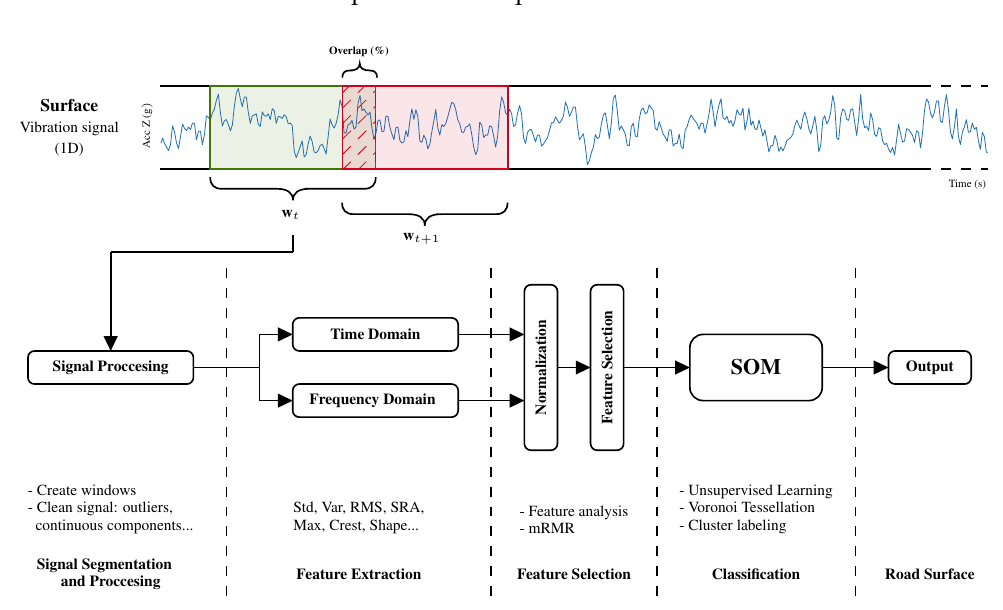
Figure 7. Workflow diagram of proposed classifier based on self-organizing